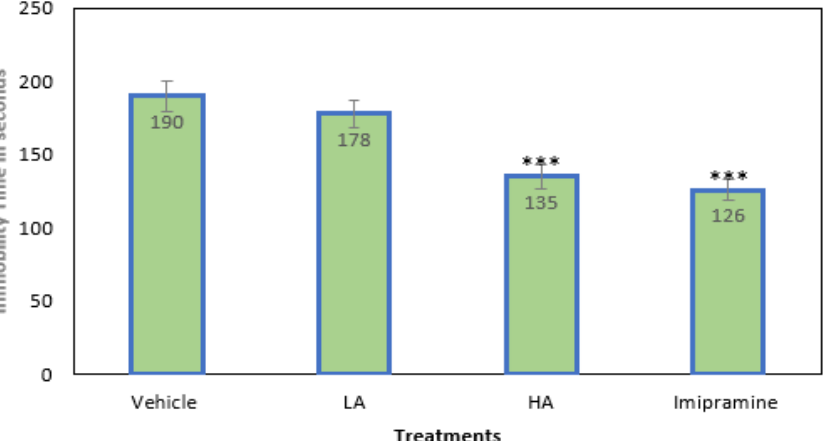
Figure 1. The effect of apigenin and imipramine on immobility period. Data are expressed in mean ± SEM (n = 8). Data were evaluated using a one-way analysis of variance (ANOVA) and Tukey’s test. *** p < 0.001 when compared to the vehicle control group. LA: low dose of Apigenin (25 mg/kg); HA: high dose of Apigenin (50 mg/kg); Imipramine: standard antidepressant (15 mg/kg); Vehicle; 0.2% carboxy methyl cellulose (CMC).